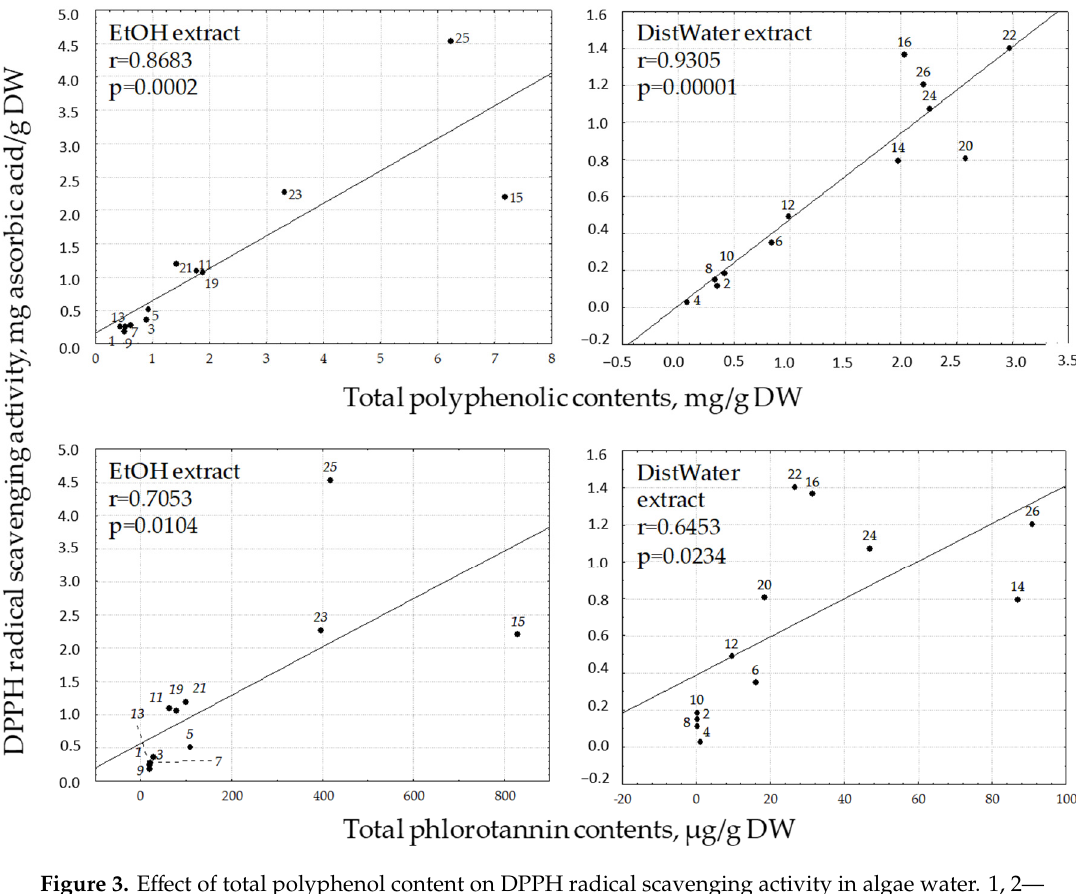
Figure 3. Effect of total polyphenol content on DPPH radical scavenging activity in algae water. 1, 2—